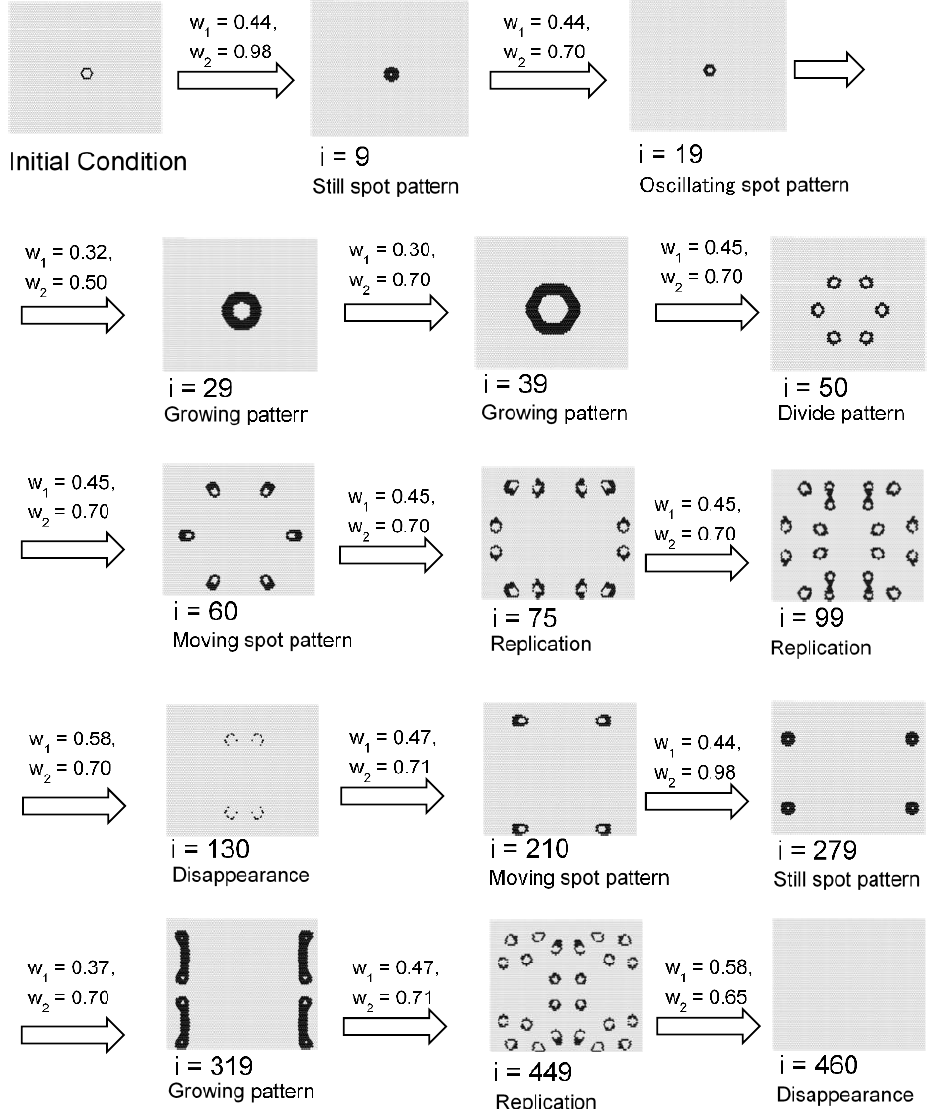
Figure 20. Calculation results in which w 1 and w 2 are changed over time at each step. The initial pattern was a hexagonal ring shape of state 1s, with s = 5 and t = 8 in a hexagonal grid. As in this result, it is possible to create changes by changing w 1 and w 2 ; when i = 1–9, w 1 = 0.44, and w 2 = 0.98, birth of annulus was observed; when i = 11–19, w 1 = 0.44, and w 2 = 0.70, an oscillating spot pattern was observed; when i = 20–29, w 1 = 0.32, and w 2 = 0.50, a growing ring pattern was observed; when i = 30–39, w 1 = 0.30, and w 2 = 0.70, a growing ring pattern was observed; when i = 40–99, w 1 = 0.45, and w 2 = 0.70, divide patterns and replication were observed; when i = 100–139, w 1 = 0.58, and w 2 = 0.70, pattern disappearance was observed; when i = 140–259, w 1 = 0.47, and w 2 = 0.71, moving spotted patterns were observed; when i = 260–279, w 1 = 0.44, and w 2 = 0.98, still circle patterns were observed; when i = 280–319, w 1 = 0.37, and w 2 = 0.70, a growing ring pattern was observed; when i = 320–449, w 1 = 0.47, and w 2 = 0.71, divide patterns and replication were observed; when i = 460–, w 1 = 0.58, and w 2 = 0.65, disappearance of all patterns was observed.